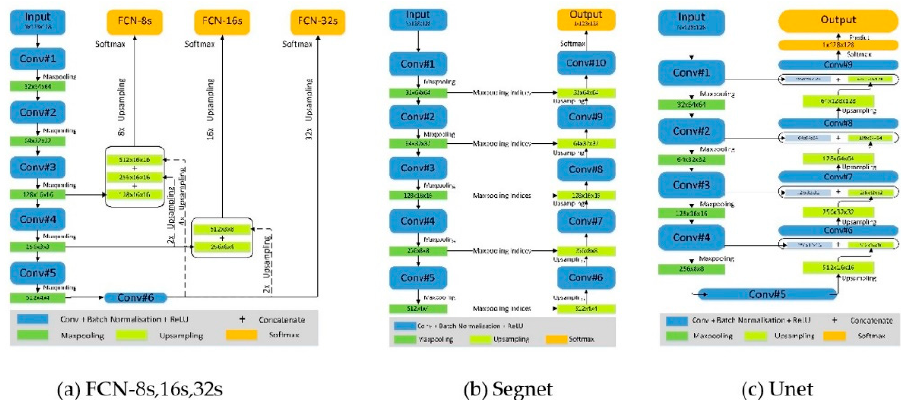
Figure 2. The architectures of fully convolutional networks (FCNs) ( a ) FCN-8,16,32s ( b ) Segnet ( c ) Unet. Input means the input image size in the FCNs, where N is the band of input images which equals 3 or 4, and the image patch size is 128 × 128. Conv indicates the convolution layer combined with batch normalization and rectified non-linear function (ReLU). Rectangles labeled with the b × w × h (b, w, and h indicate the feature channel number, image width, and height, respectively) are the output size after max pooling or the upsampling method. The symbol “+” in ( a ), ( c ) indicates different concatenation features at the feature channel dimension. “Maxpooling indices” in ( b ) indicates the locations of the maximum feature value in each pooling window. They are memorized in the max pooling stage and then used in the upsampling stage.